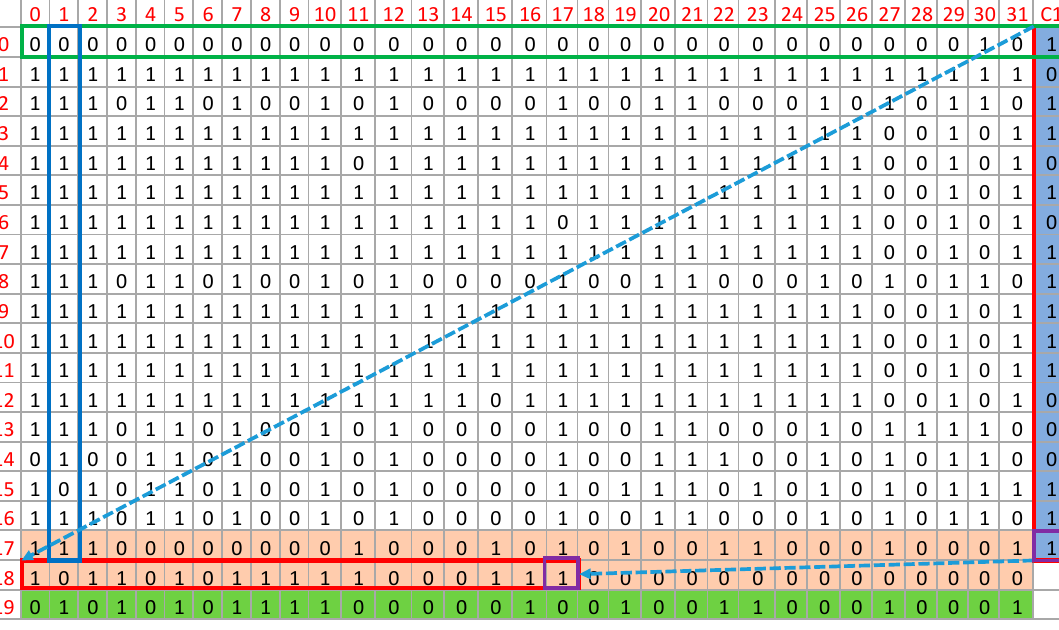
Figure 3. 2D-parity check applied to non-volatile memory (NVM).